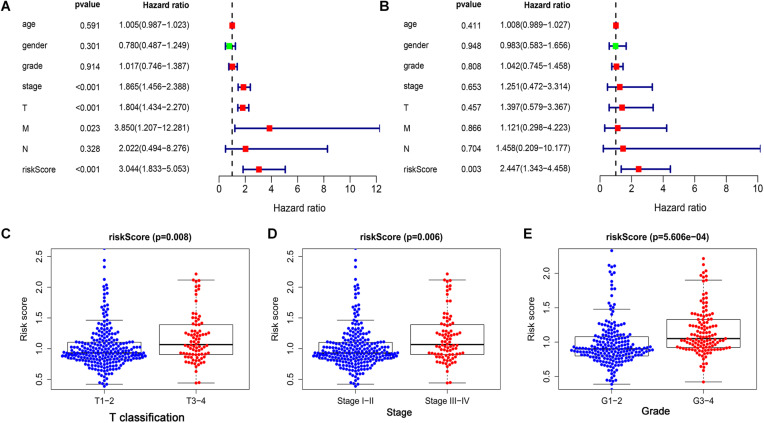
The prognostic value of the risk score was assessed in LIHC. (A) The correlation between clinical parameters and risk score were assessed through a univariate Cox regression and (B) multivariate Cox-regression. (C) The correlation between risk score and T classification. (D) The correlation between risk score and clinical stage. (E) The correlation between risk score and histological grade.